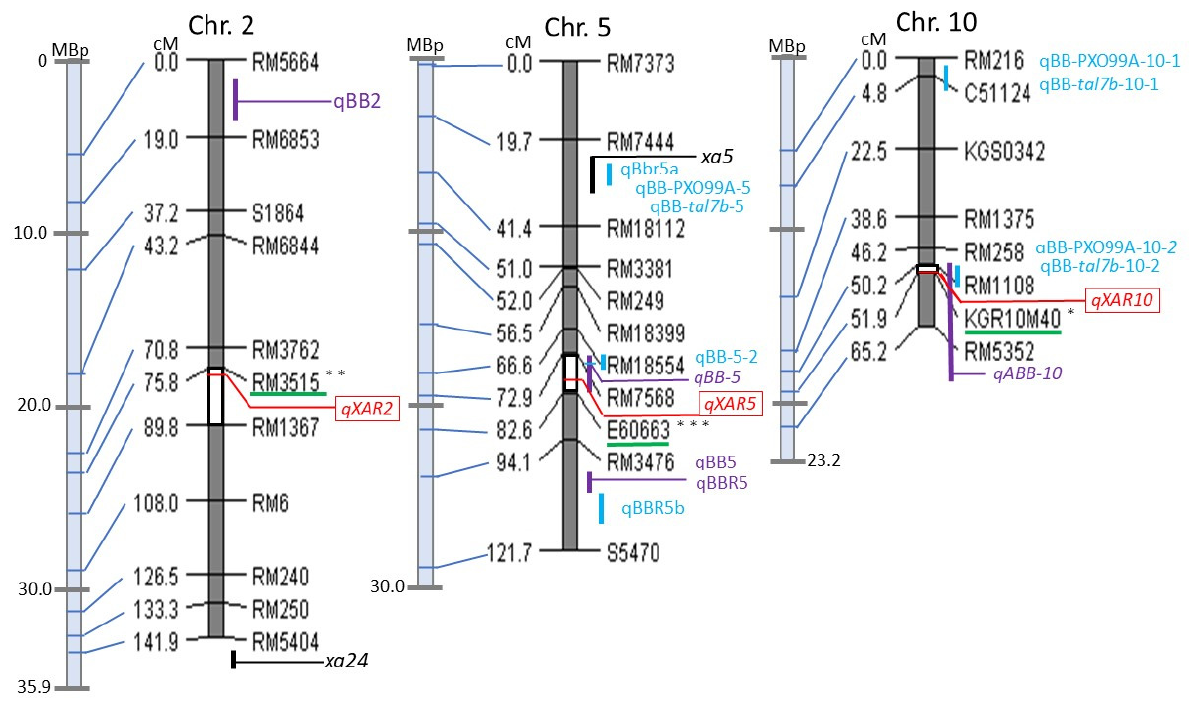
Figure 5. An associative map comparing the QTLs against Xoo pathogen in this study with Xoo resistance genes published before. The left vertical categorized light blue thick lines represent the Nipponbare physical map [33] of chromosomes 2, 5, and 10 and are linked to the genetic map on the right showing DNA markers for QTLs controlling elongation of lesion length, which is constructed using AntMap [34] with the Kosambi function [35]. The chromosomes are represented as dark grey bars with SSR, InDel markers used in this work are presented on the right side. The genetic distance (cM) is indicated at the left of the bar. QTLs found in this study are shown as red boxes; the Bayesian 99% interval of QTLs is represented as filled-in white within the chromosome bars. The nearest genetic marker to QTLs discovered in this study is underlined with green. Markers that are significant at the 0.001, 0.01, and 0.05 probability level are marked with ***, **, *, respectively. The previously published QTL genes that are not fine mapped are labelled as vertical blue and purple lines indicating the confidence interval. R resistance genes associated with BB resistance are shown as black lines on chromosomes of interest for this study. Table 2. QTLs controlling lesion length after inoculation of Xoo race